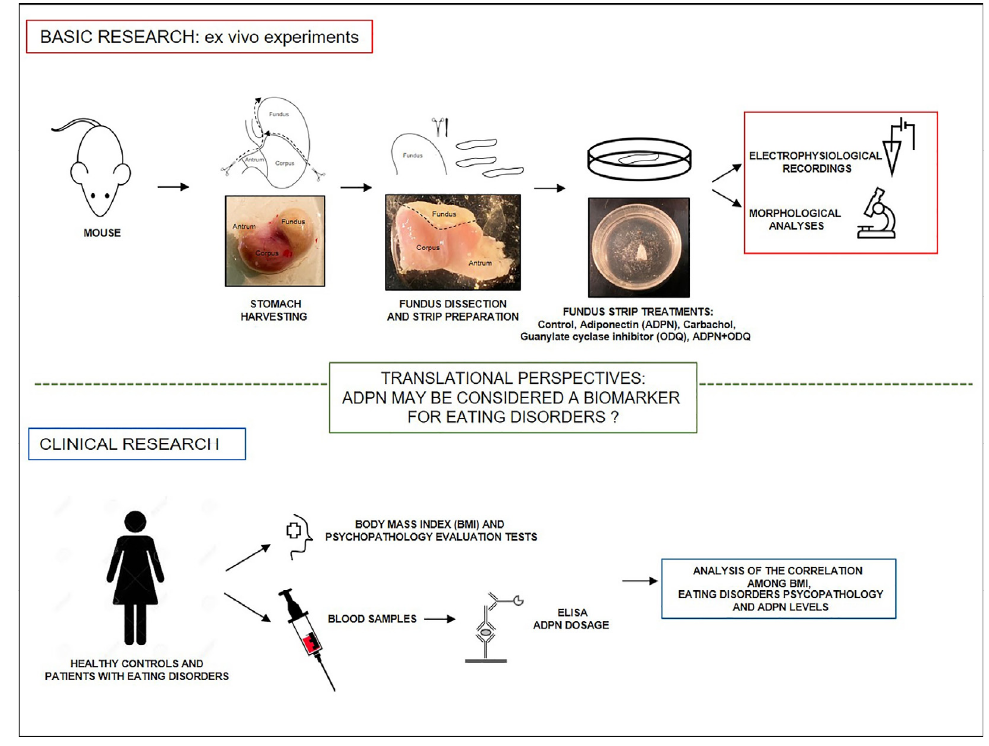
Figure 1. Experimental design of this study.